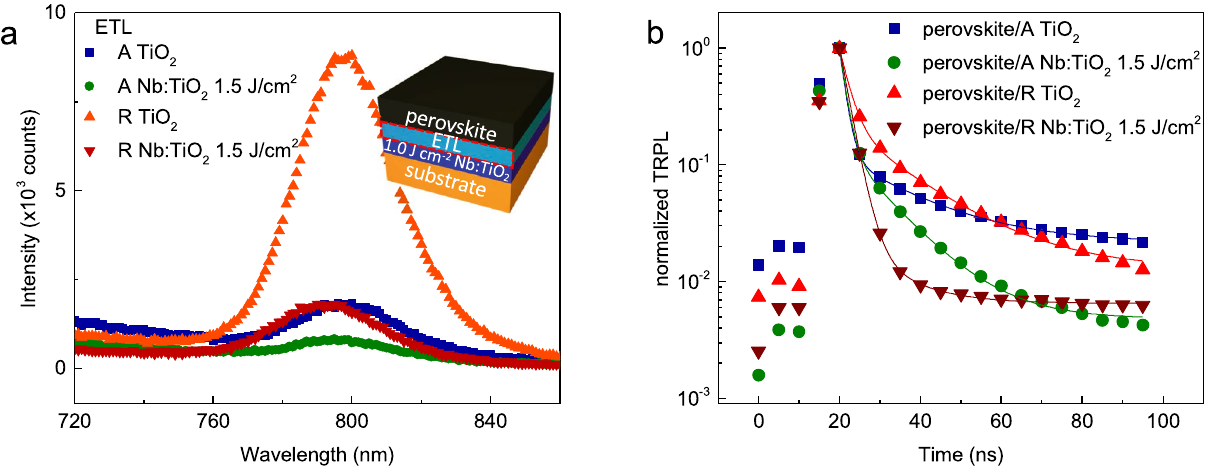
Figure 3. PL and TRPL results. A and R denote the anatase and the rutile phases respectively. ( a ) Steady-state PL spectra. ( b ) Normalized TRPL spectra of perovskite films on various ETLs. Lines indicate double exponential fitting results. A schematic of the HPSC is shown in the inset of ( a ).